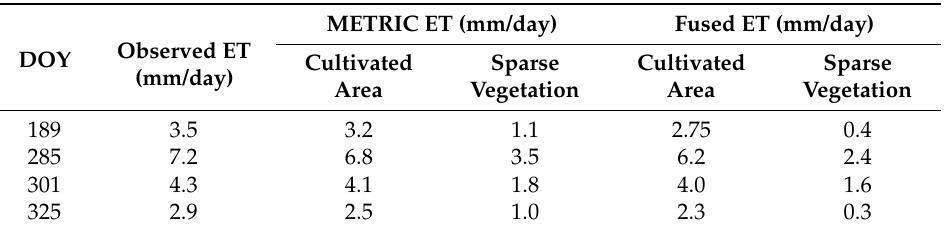
Figure 8. Comparison of ET maps generated using the METRIC model, non-fusion approach Landsat only (left column imagery), and using the fusion model with four Landsat images and 8-day cycle of MODIS data updates (right column imagery). Table 3. Evapotranspiration (ET) values resulted from using mapping evapotranspiration with internalized calibration (METRIC) model and modified fusion